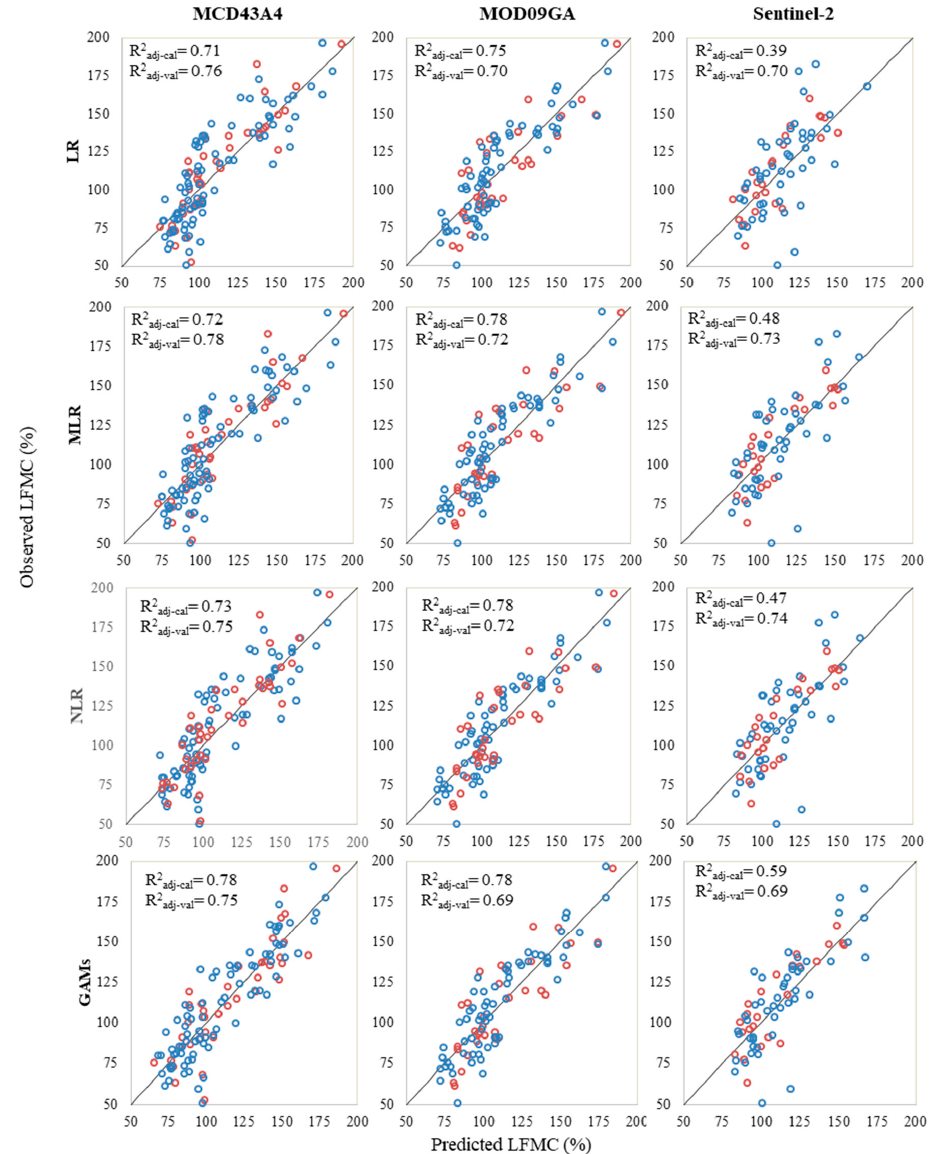
Figure 4. Observed vs. predicted values of LFMC using the best empirical model obtained for each type of surface reflectance source and method used (LR, MLR, NLR, and GAMs). Blue and red circles depict calibration and validation data,